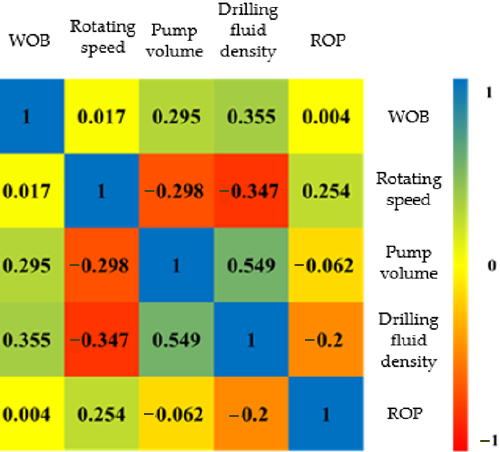
Figure 8. Section 1 of Liushagang Formation and Upper part of Section 2 of Liushagang Formation.